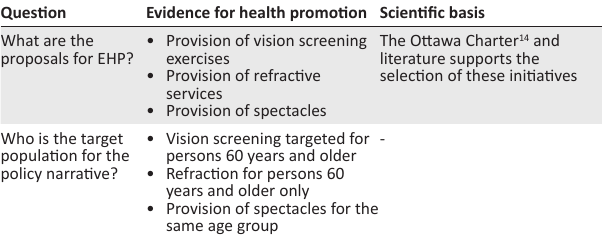
TABLE 3: Analysis of the guideline on refractive errors screening for persons 60 years and older.